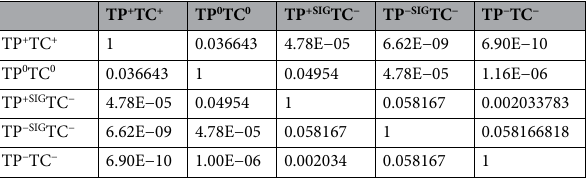
Table 3. Experiment 2: Sequential Bonferonni adjusted probability values for pairwise